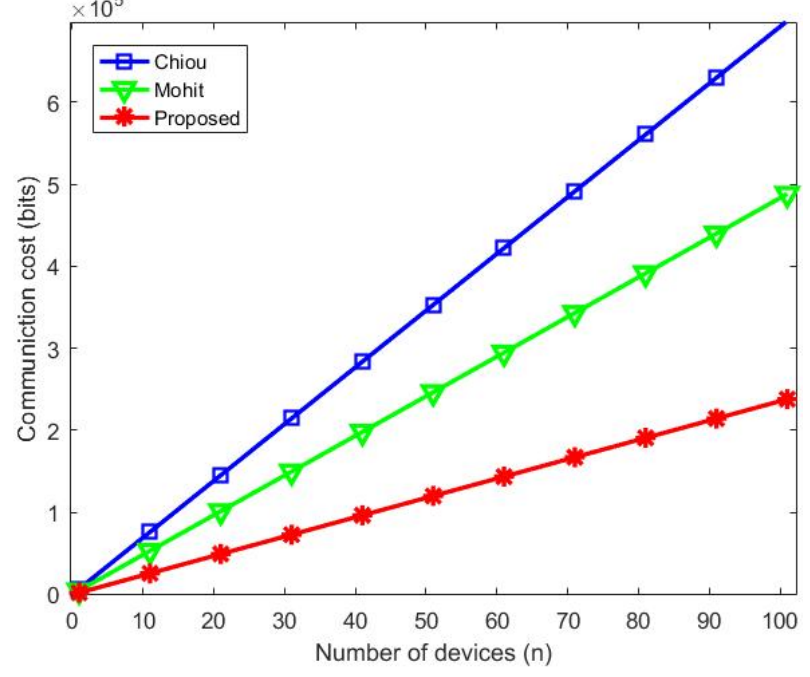
Figure 8. Communication cost comparison.